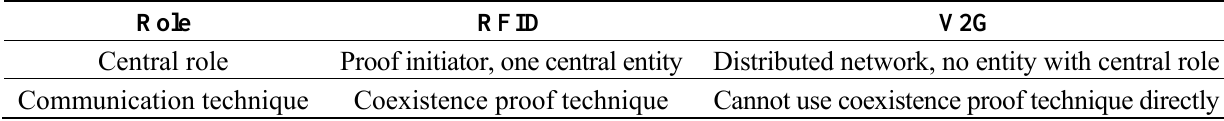
Table 2. Radio frequency identifier (RFID) vs.